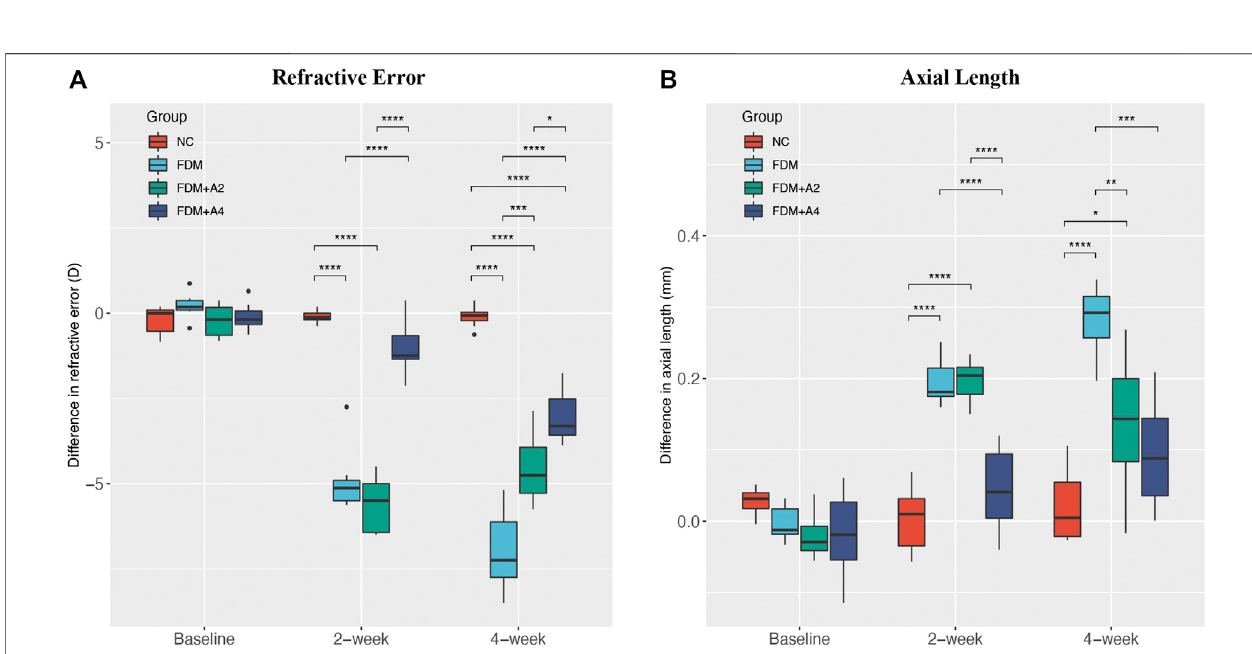
FIGURE2| Theeffectofdifferenttreatmentsonthemeandifferencebetweenthelens-wearingandfelloweyein (A) refractiveerror, (B) axiallength(AL)atbaseline, after 2-weeks (FDM + A2) and 4-weeks (FDM + A4) atropine treatment compared with normal control (NC) ( n = 7), FDM ( n = 7), FDM + A2 ( n = 7), FDM + A4 ( n = 8) and groups. (mean ± SD, Two-way mixed-design ANOVA with Bonferroni multiple comparison, * p < 0.05, ** p < 0.01, *** p < 0.001).